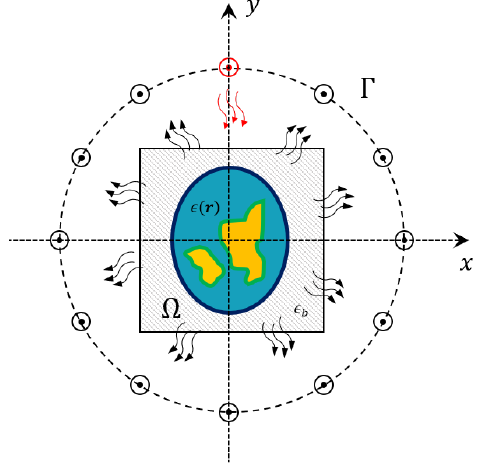
Figure 1. Sketch of the 2D geometry. The antennas are located on the measurement line Γ and arranged in a multiview-multistatic